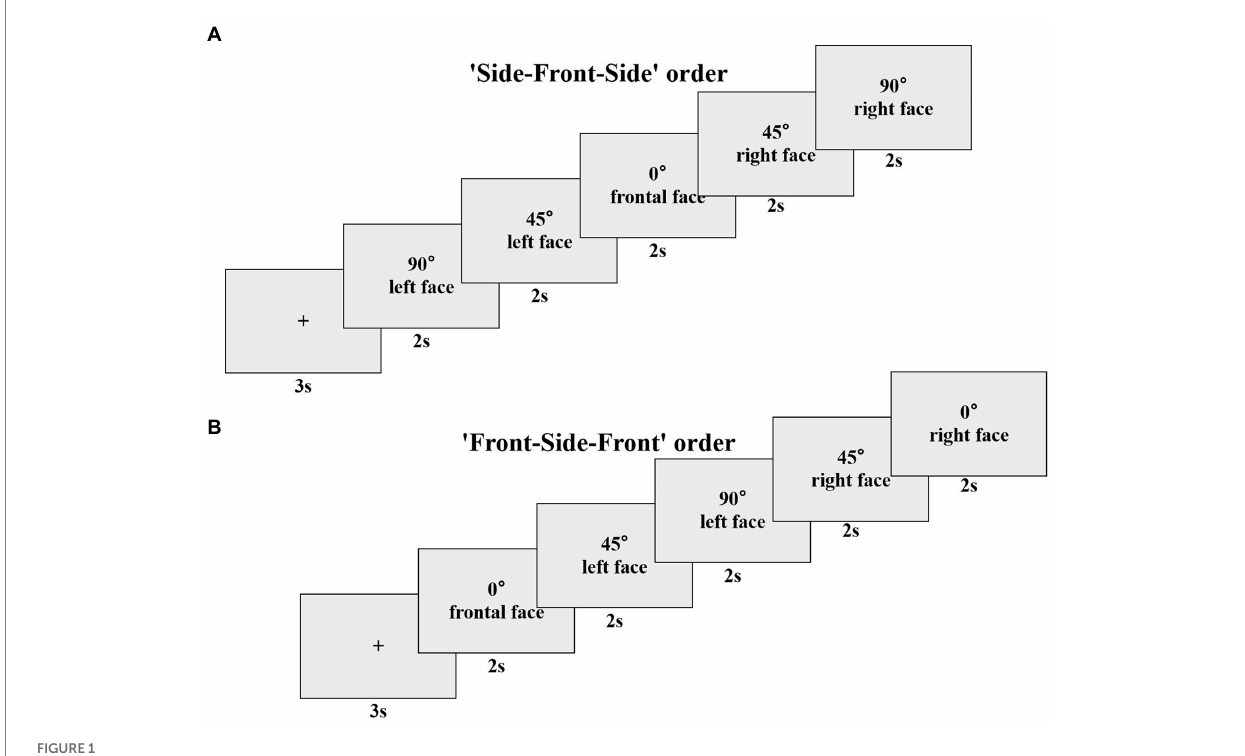
FIGURE 1 The possible trial of the ‘Side-Front-Side’ order (A) and the ‘Front-Side-Front’ order (B)